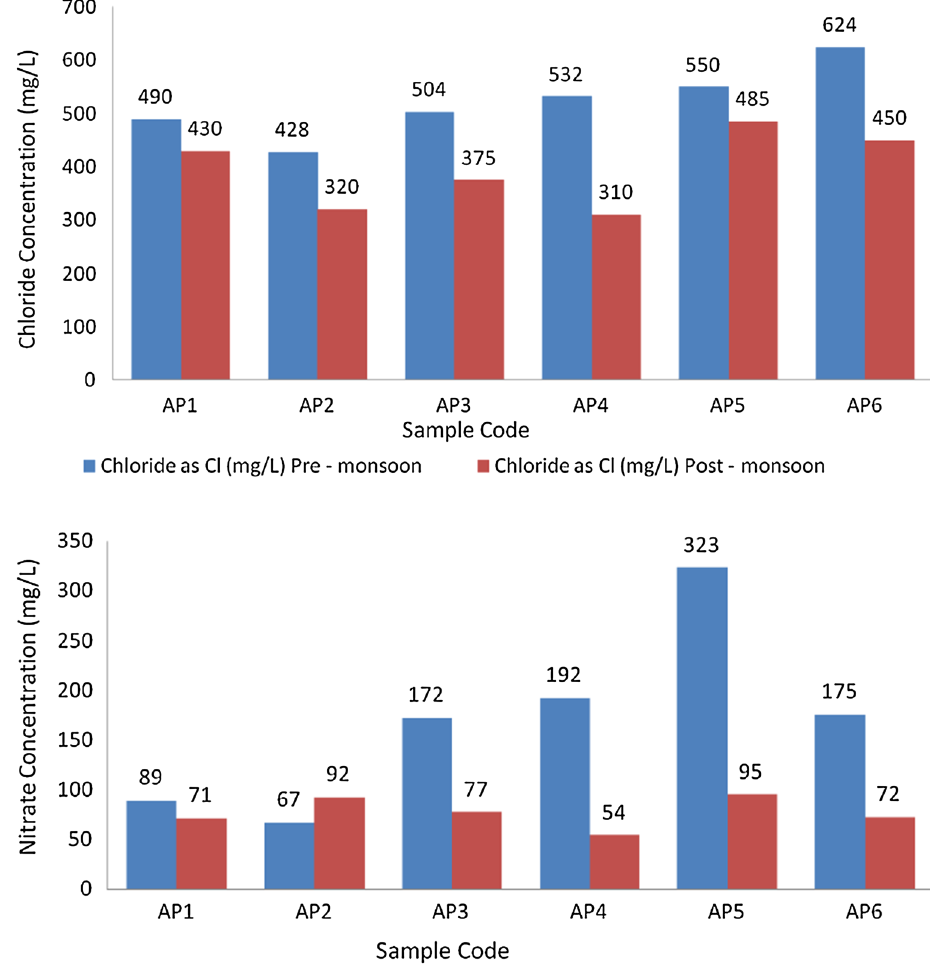
Fig. 6 Chloride concentration in samples BIS limit (1000 mg/ L) collected from Pandav Nagar